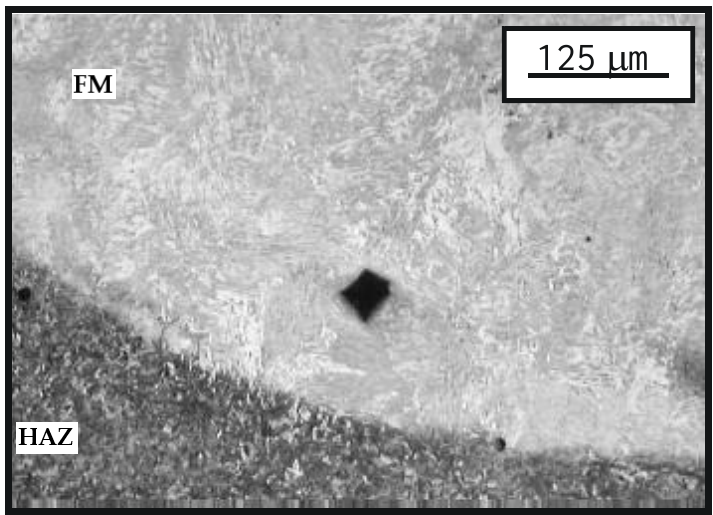
Figure 13. Microstructure of the transition zone between the hard-faced layer executed by the FM EVB2CrMo (light area) and the base metal (HAZ); state: hard-faced + soft-annealed + cemented + heat